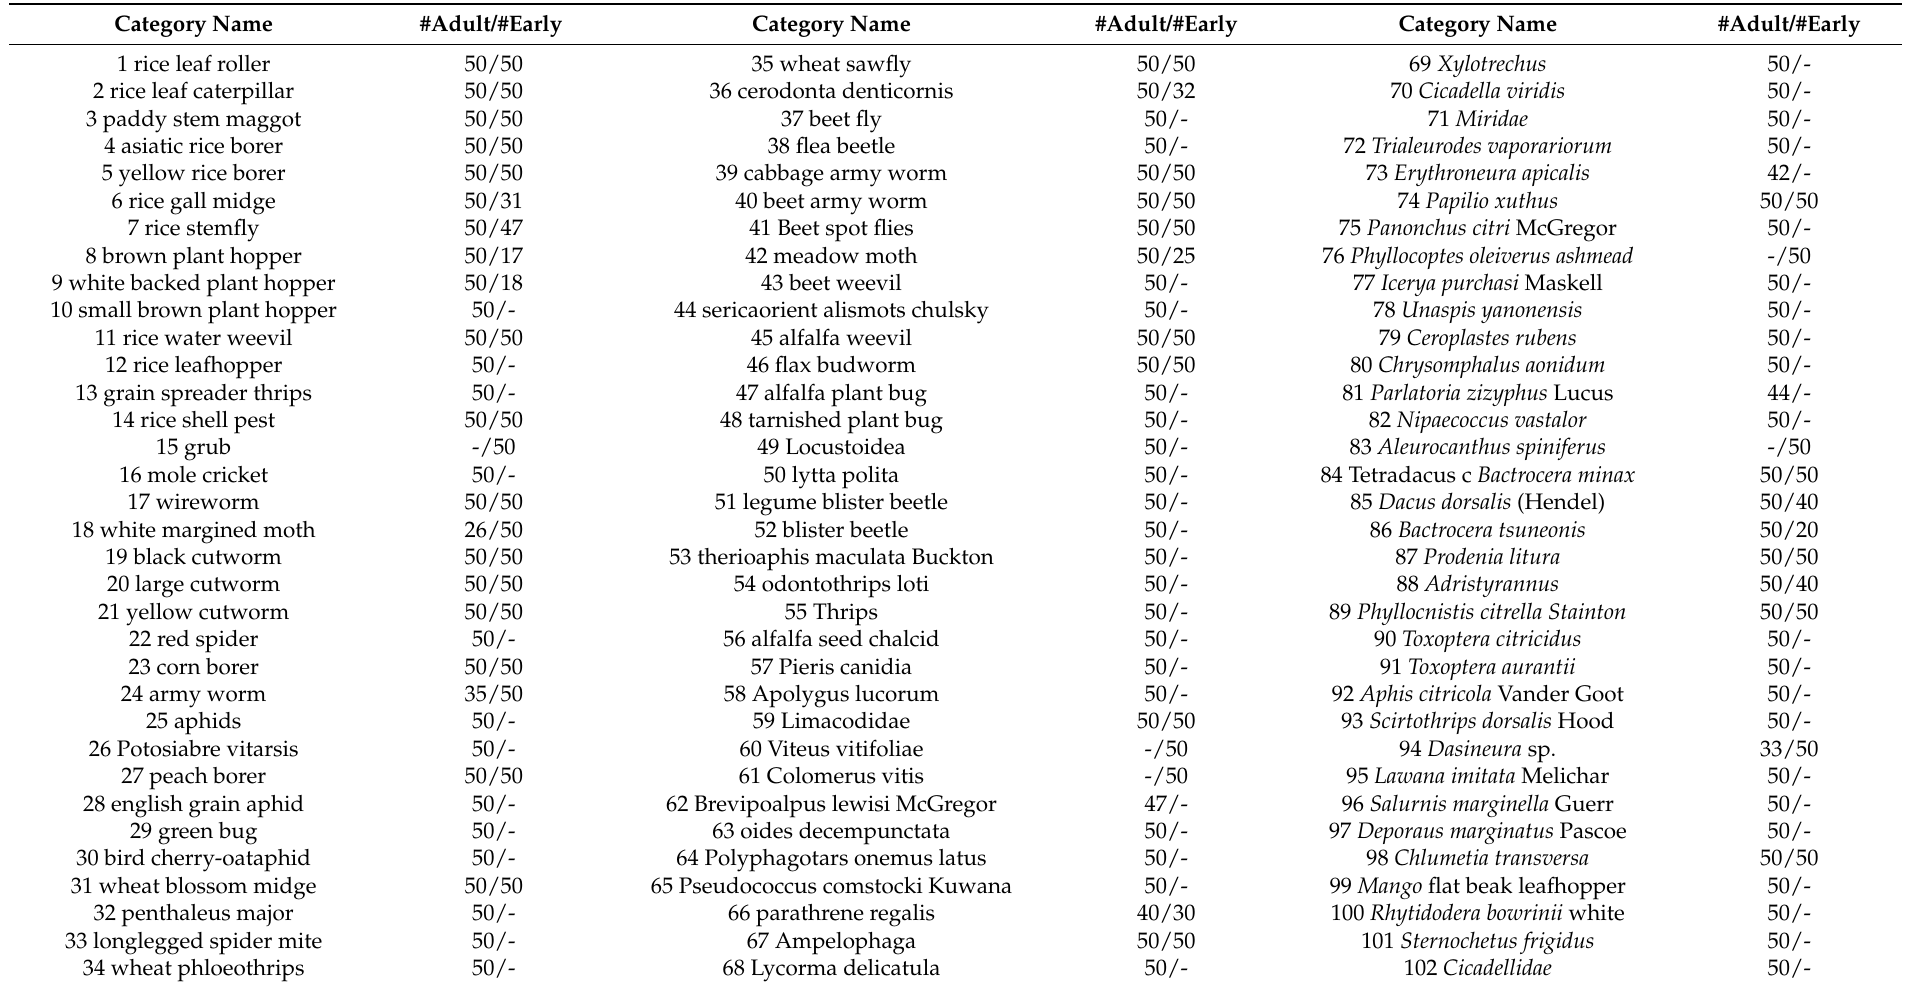
Table 1. IP-FSL image data set information, derived from IP102 (Insect Pest 102) [15], assembled specifically for this few-shot learning research. The names of the insects were kept as published in the original source (IP102), and in the categories may contain common, as well as scientific,